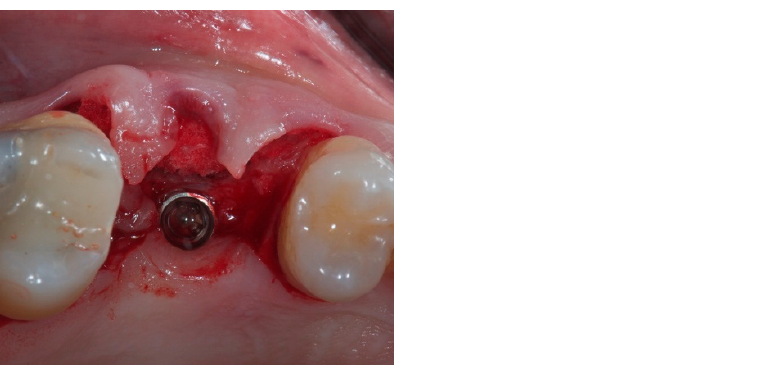
Figure 3. Intraoral occlusal view of the flap design. The collagen matrix is visible at the buccal aspect of the implant inside the soft tissue envelope soaked by the blood clot. Once the CM was placed inside the envelope, the suture (6-0 polyglycolic acid) had the only role of repositioning the mesial and distal papilla apically according to the augmented buccal volume. The temporary resin crown was finally screwed to the implant in order to sustain the volumetric increase of the soft tissues (Figure 4a,b).